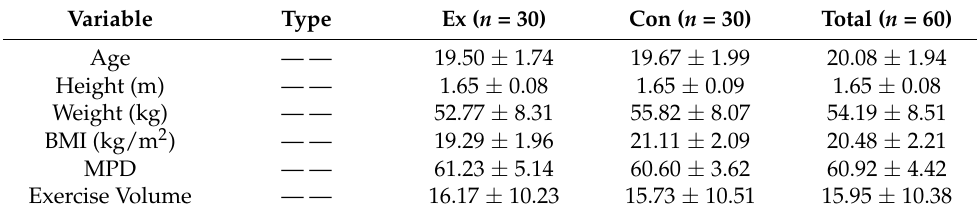
Table 1. Demographic characteristics of subjects.